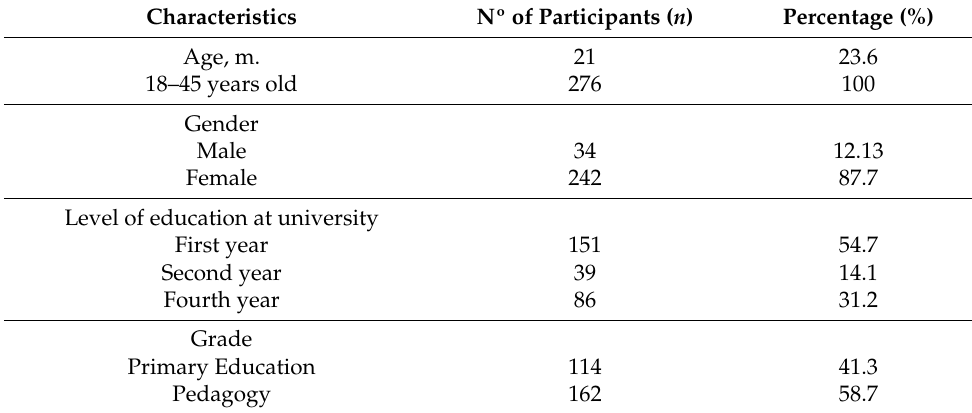
Table 1. Socio-demographic characteristics of the participants ( n =